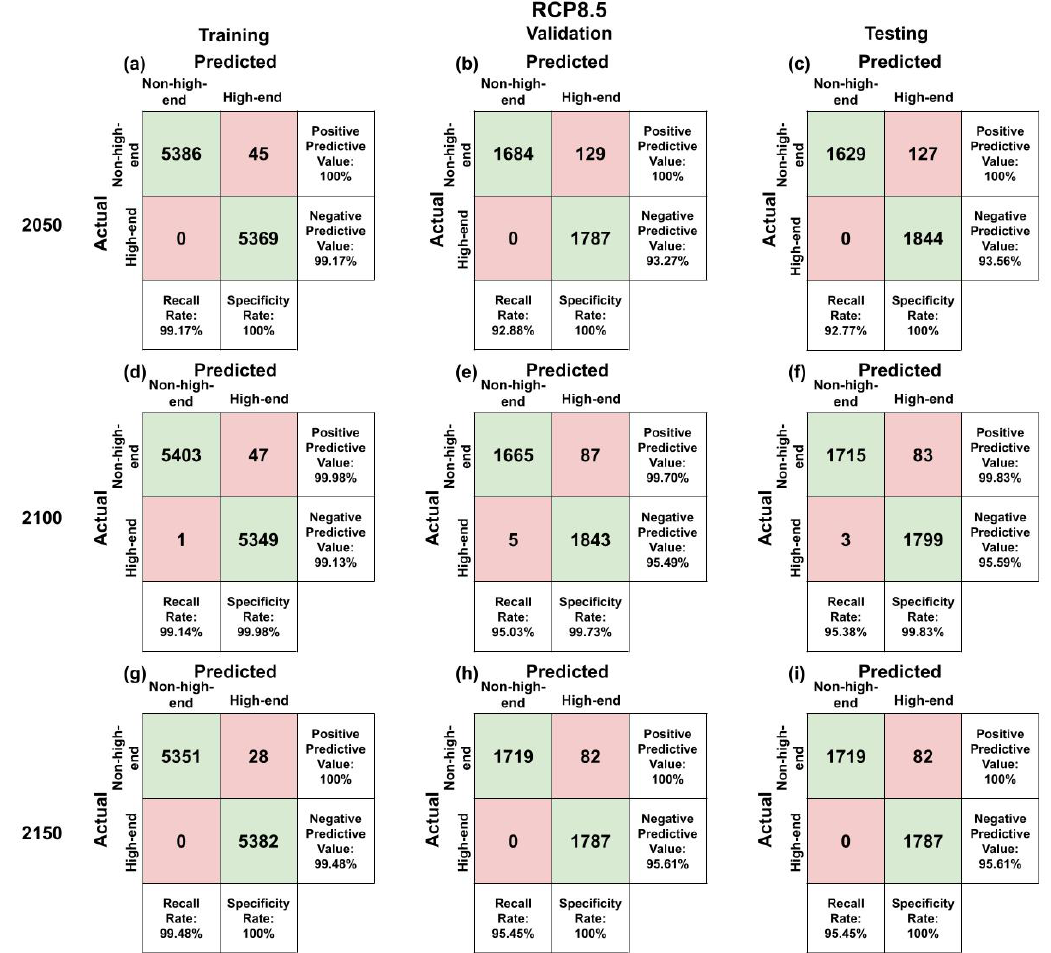
Figure A3. Random forests’ confusion matrices on the RCP8.5 training, validation, and testing subsets.